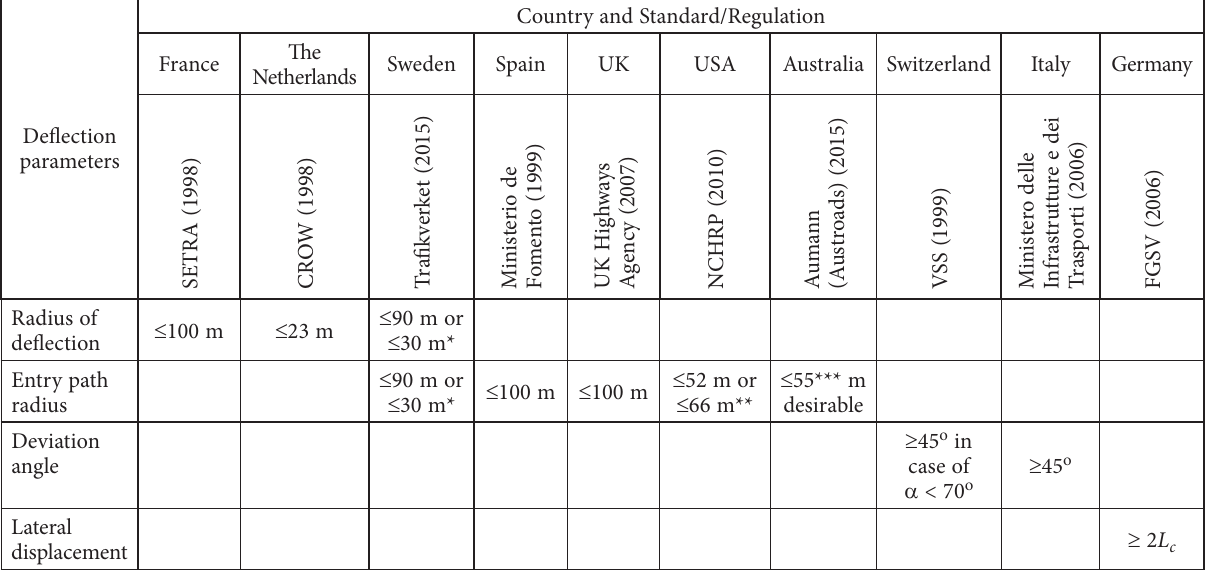
Deflection parameters